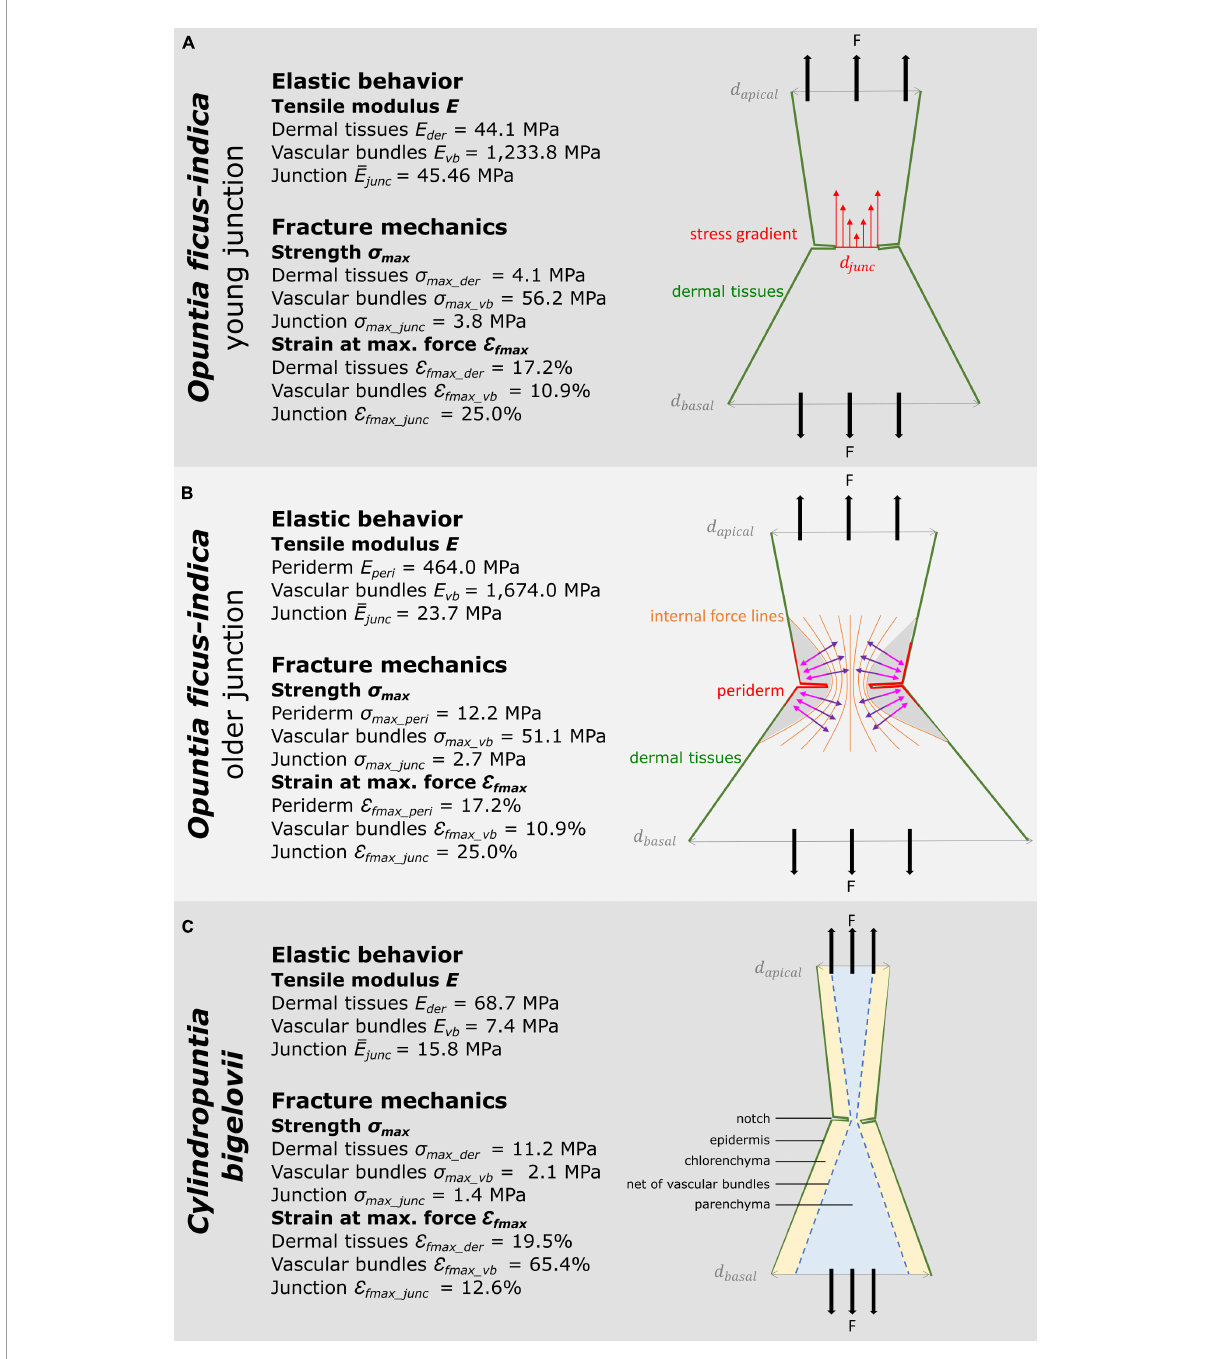
FIGURE9 Schematic drawings of the investigated cactus samples with medians of the material properties of tissues (Mylo et al., 2021a) and of entire junction samples derived from the tensile tests. The sub-images illustrate various aspects of the notch effect. (A) Young junction of Opuntia ficus-indica . Here, we illustrate the stress distribution in the circumferential notch. Since the diameter of the junction d junc is smaller than the apical d apical and the basal diameter d basal , a stress gradient (red arrows) results, and the notch stresses reveal peak values. (B) Older junction of O. ficus-indica . In this sub-image, we visualize the influence of the notches, as intensified by the stiff periderm coating, on the internal force lines. According to their Poisson’s ratio, the junctions show a transverse contraction (purple arrows) with simultaneous longitudinal elongation under tensile loading. However, the gray-marked zones are not stretched in the longitudinal direction by the tensile loading. Instead, they generate a transverse force directed outward (pink arrows) preventing transverse contraction in this area (after “Kerbwirkung” by Ralf Pfeifer, licensed under CC BY-SA 3.0, available at https://commons.wikimedia.org/wiki/File:Kerbwirkung.svg). (C) Junction of Cylindropuntia bigelovii . This sub-figure focuses on the distribution and structure of the five tissue layers. Under high tensile loading, the dermal tissues can first